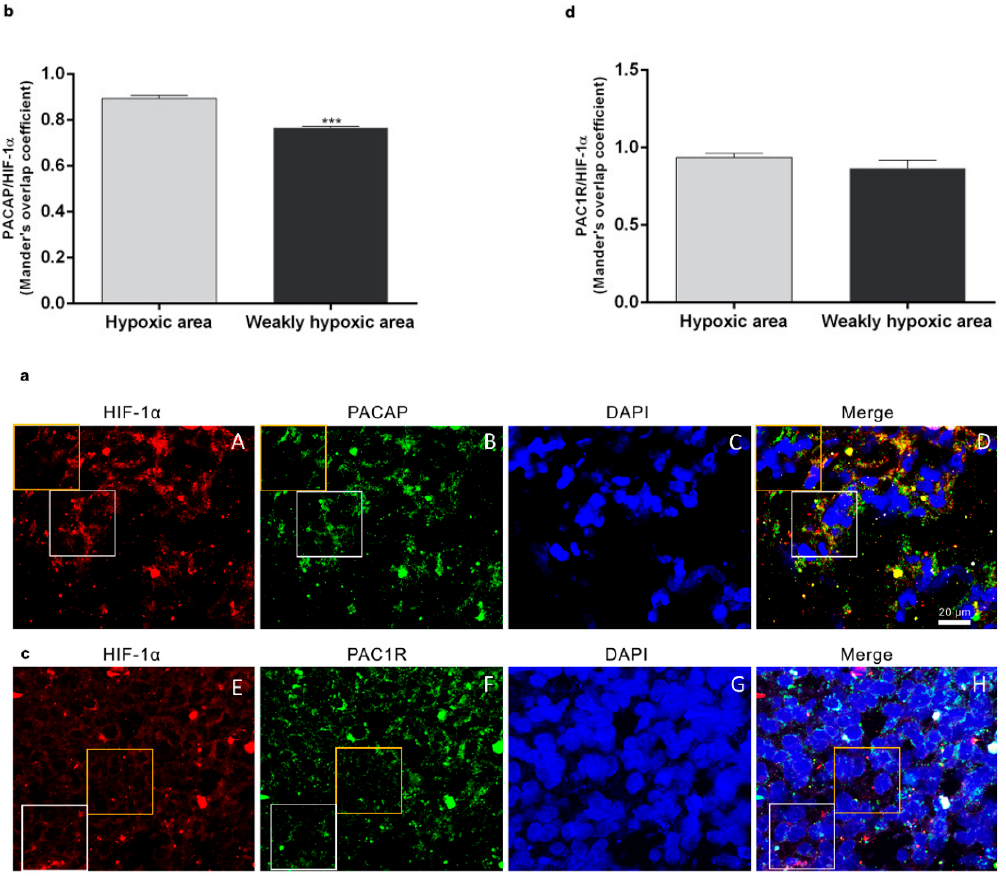
Figure 1. Expression of PACAP and PAC1R in hypoxic area of human GBM sections. ( a , c ) Representative photomicrographs showing PACAP (panel B, green), PAC1R (panel F, green), and HIF-1 α expression (panels A and E, red) in fresh-frozen sections of a surgically resected GBM. Nuclei were stained with DAPI. The white square indicates a representative hypoxic area showing a higher HIF-1 α expression in contrast to a non-hypoxic area limited by a yellow square representing a region with a weak HIF-1 α expression. Photomicrographs are representative results of fields taken randomly from each slide and scanned by confocal laser scanning microscopy (CLSM; Zeiss LSM700). ( b , d ) PACAP/HIF-1 α and PAC1R/HIF-1 α expression in hypoxic and weakly hypoxic regions were analyzed by using Mander’s overlap coefficient. Data represent mean ± S.E.M. (*** p < 0.001).